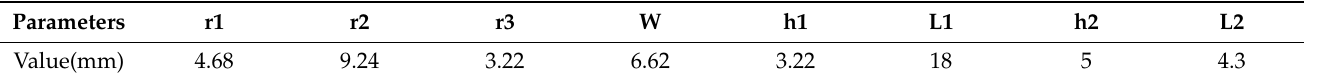
Table 1. Antenna parameters (unit: